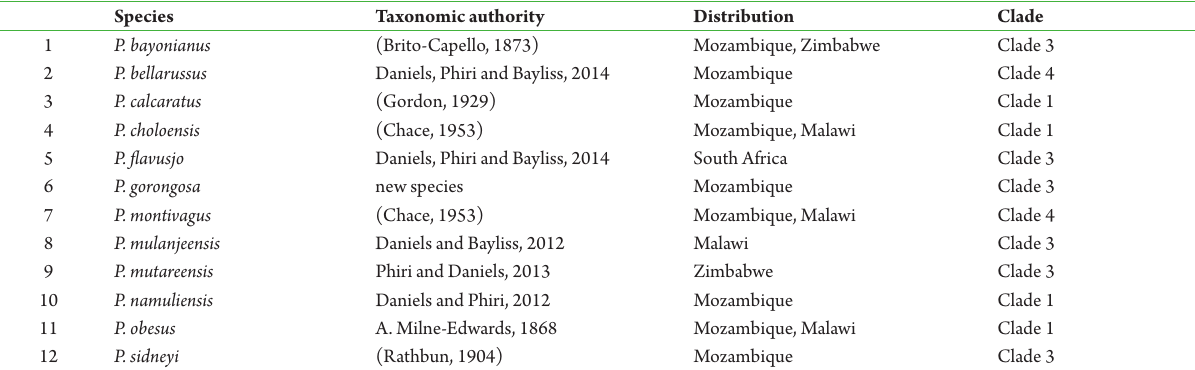
Table 1. Updated list of the nine species of freshwater crabs from Mozambique and the phylogenetic lineage to which they belong. Potamonautes gorongosa new species, is referred to as “ Potamonautes sp. 2” in Daniels et al . (2015). Also included are the sister species of P. gorongosa new species, from elsewhere in southern Africa. The clade column refers to clade number recovered by Daniels et al .